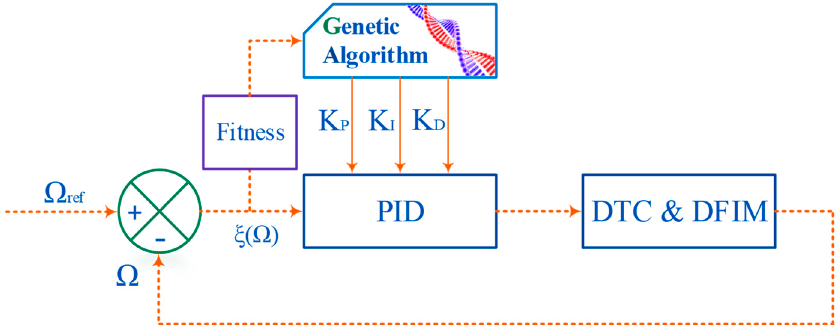
Figure 2. Optimization of the PID controller parameters by the GA.